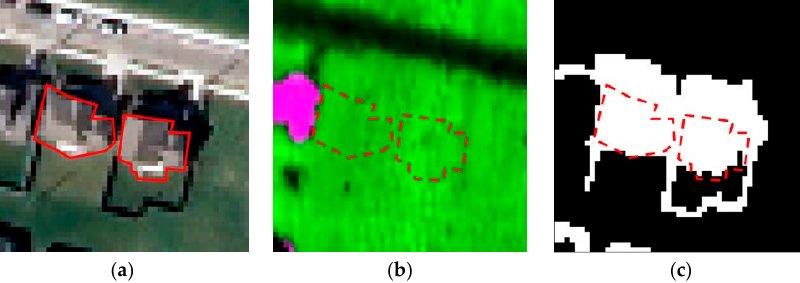
Figure 8. The spatial correspondence for the changed areas between multi-temporal LiDAR data and the high-resolution image: ( a ) high-resolution image; ( b ) LiDAR data; and, ( c ) mask for changed area. The red rectangle indicates the schematic object from the high-resolution image.